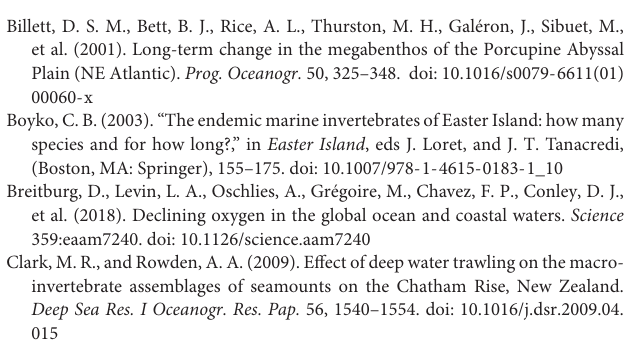
Supplementary Table 3 | “enviro”: averages of each environmental variable (salinity, chlorophyll-a, sea surface temperature, and temperature at 300 m depth) for each station. This data was used as predictors in the analyses. Supplementary Table 4 | “dat_pca”: CARS data including seasonal variation at each sampling station. This data was used to construct the PCA in Supplementary Figure 1